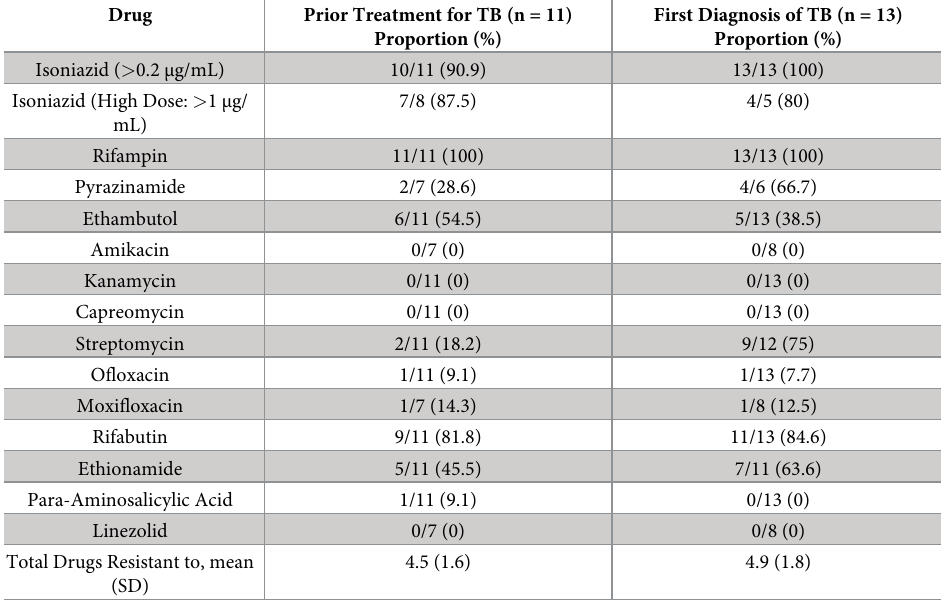
Table 2. Resistance to antimycobacterials, by prior treatment status. Drug Prior Treatment for TB (n = 11) First Diagnosis of TB (n = 13) Proportion (%) Proportion (%) Isoniazid ( > 0.2 μ g/mL) 10/11 (90.9) 13/13 (100) Isoniazid (High Dose: > 1 μ g/ 7/8 (87.5) 4/5 (80) mL) Rifampin 11/11 (100) 13/13 (100) Pyrazinamide 2/7 (28.6) 4/6 (66.7) Ethambutol 6/11 (54.5) 5/13 (38.5) Amikacin 0/7 (0) 0/8 (0) Kanamycin 0/11 (0) 0/13 (0) Capreomycin 0/11 (0) 0/13 (0) Streptomycin 2/11 (18.2) 9/12 (75) Ofloxacin 1/11 (9.1) 1/13 (7.7) Moxifloxacin 1/7 (14.3) 1/8 (12.5) Rifabutin 9/11 (81.8) 11/13 (84.6) Ethionamide 5/11 (45.5) 7/11 (63.6) Para-Aminosalicylic Acid 1/11 (9.1) 0/13 (0) Linezolid 0/7 (0) 0/8 (0) Total Drugs Resistant to, mean 4.5 (1.6) 4.9 (1.8) (SD) Not all drugs listed had susceptibilities available for all isolates (indicated when numbers do not add up to total patient